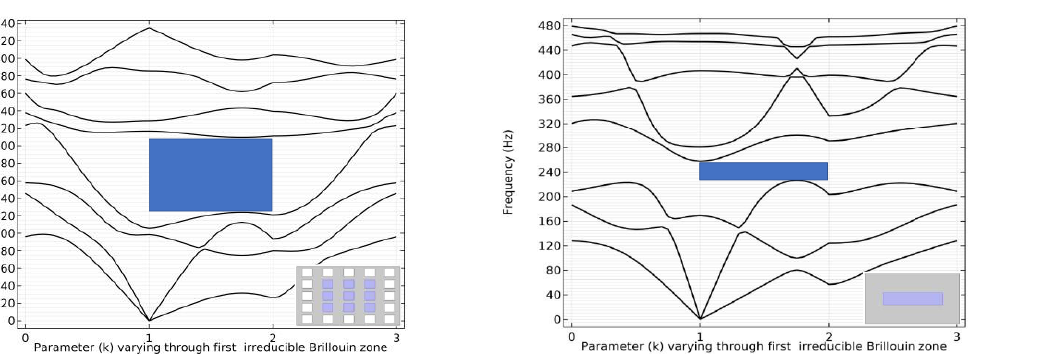
Figure 7. Dispersion relationship of the proposed model.